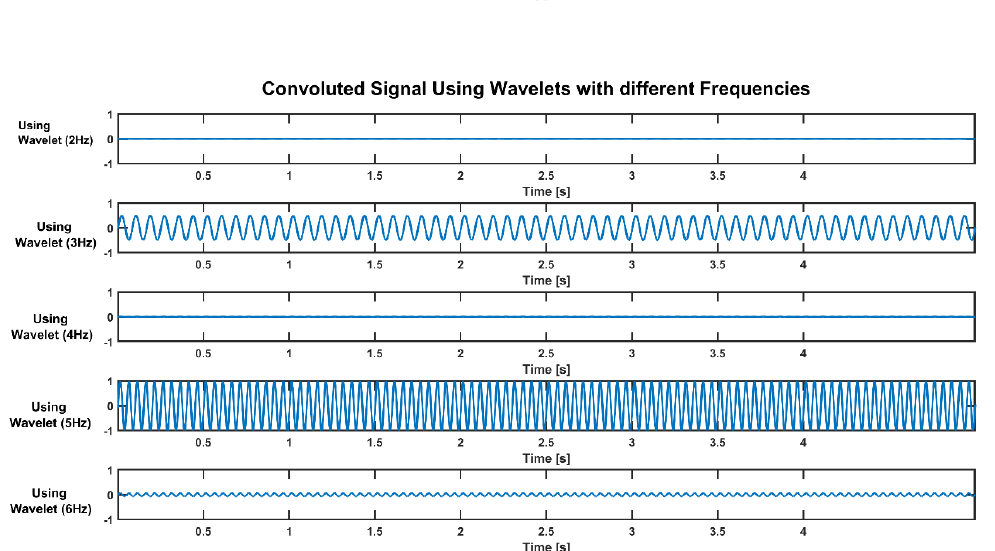
Figure 10. Convoluted signals using wavelets with different frequencies.